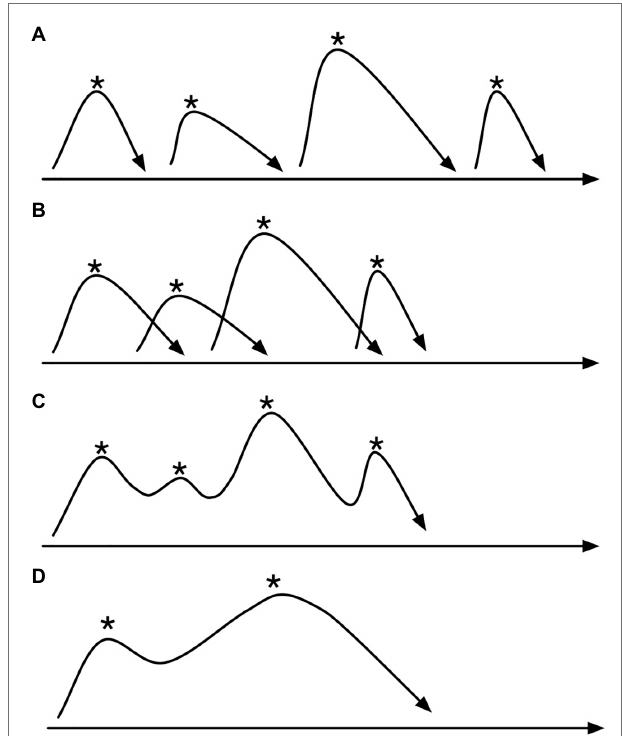
FIGURE 3 | A schematic image of emergent coarticulation, starting with four separate events along a time line from left to right such as in (A) , each event centered on a goal posture marked with an asterisk, then moved closer together in time in (B) , with the consequence that the partially overlapping trajectories become more like a continuous trajectory in (C) , and resulting in an even more smoothed trajectory in (D) , thus illustrating the event fusion phenomenon of